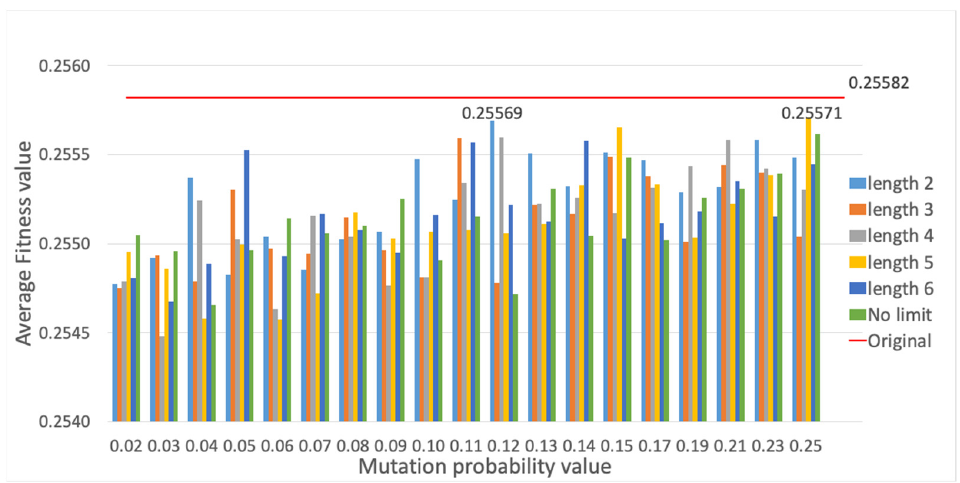
Figure 17. Average fitness value of the best individual for SM method vs. different mutation probability values.